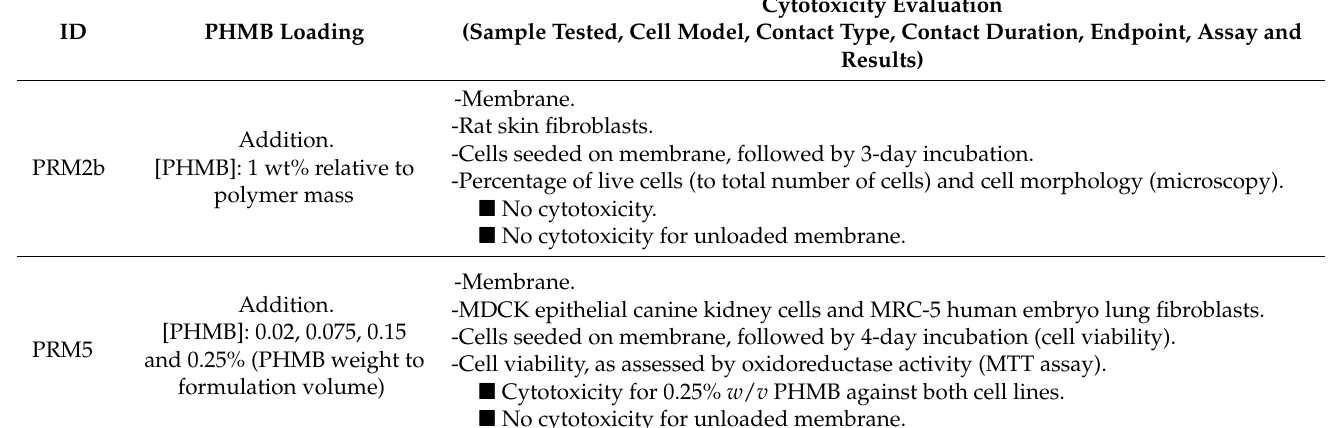
Table 9. Cytotoxicity evaluation of PHMB-releasing membranes (PRMs) developed for antimicrobial dressings (AMDs). Membrane IDs and corresponding bibliographic references are the same as in Table 3.